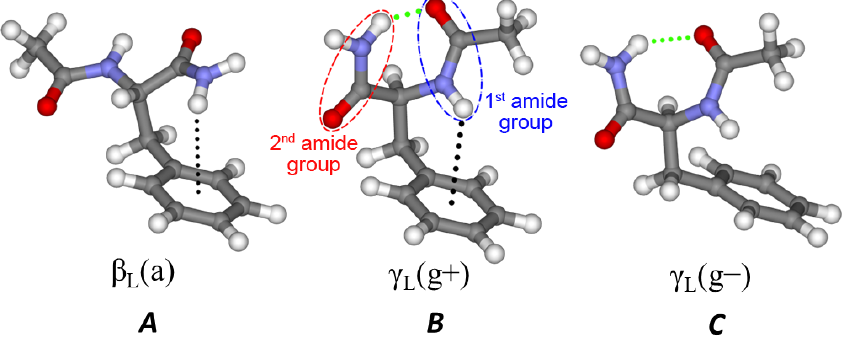
Figure 2. NAPA conformers A ( β L ( a ) ); B ( γ L ( g +) ) and C ( γ L ( g − ) ). The green dotted lines represent